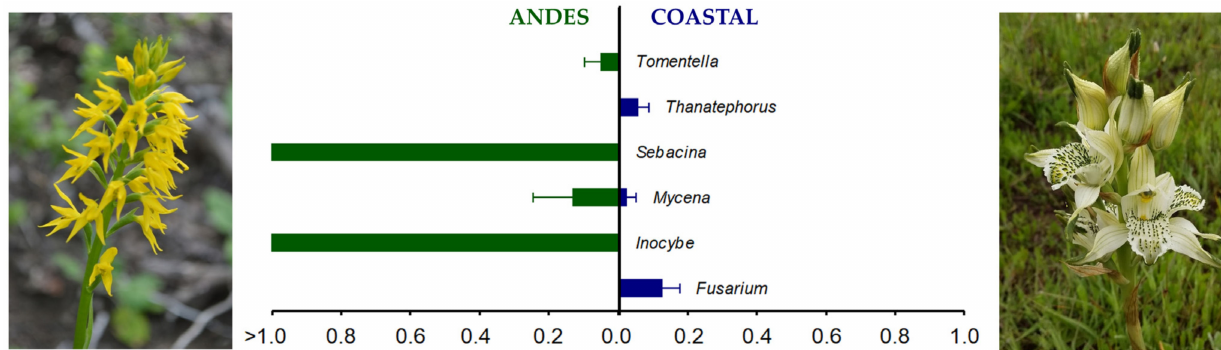
Figure 2. Relative abundance of the ITS sequences of different orchid mycorrhizal taxa in the rhizosphere of orchids growing in the Andes ( Gavilea lutea ) and Coastal Cordillera ( Chloraea collicensis ) in the region of La Araucan í a, south-central